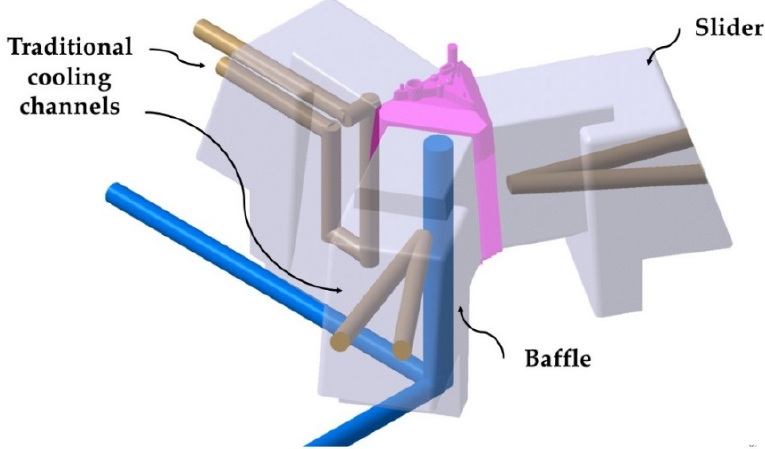
Figure 4. Current layout of the traditional cooling of the core and sliders of the mold.